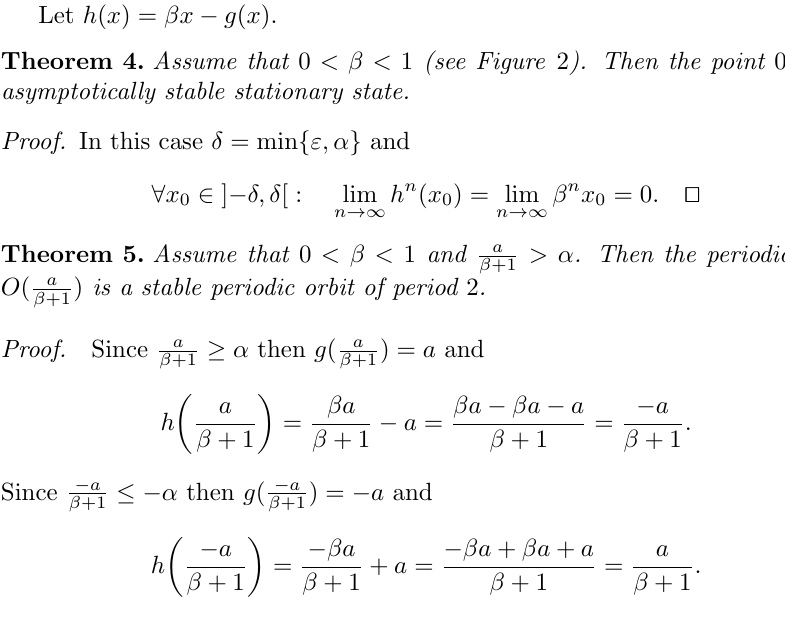
Figure 2. Illustration of Theorem 4: example of a graph of function h ( x ) = βx − g ( x ), if 0 < β < 1. Let h ( x ) = βx − g ( x